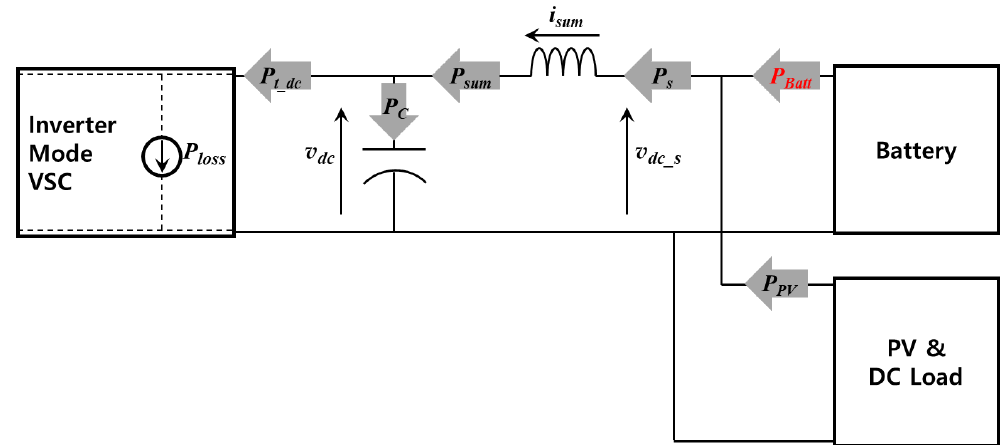
Figure 9. Power Flow in Schematic Diagram of Modeled DC Power System.